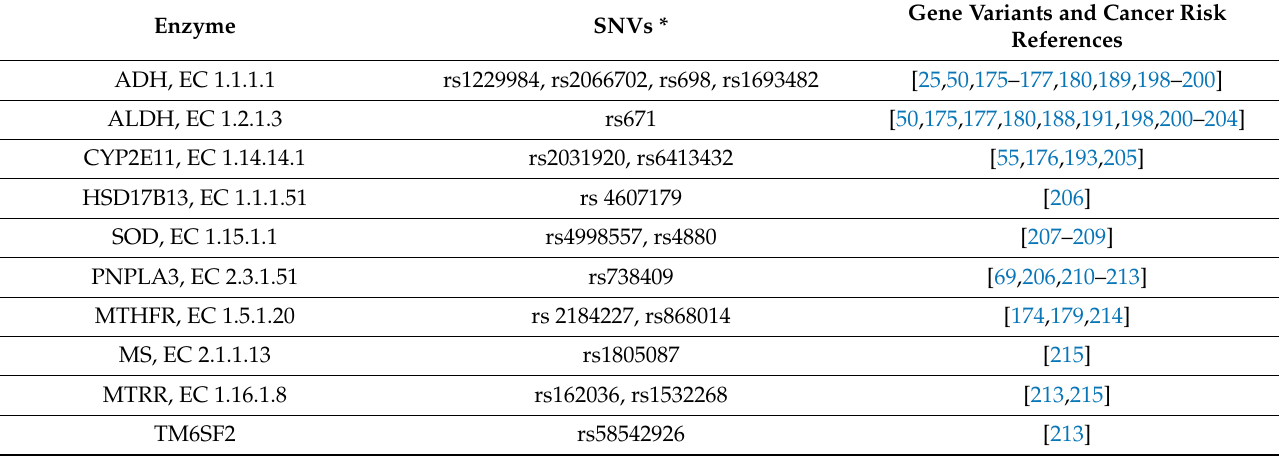
Table 1. Representative examples of enzyme variants liaised to cancer risk participating in alcohol metabolism or other metabolic pathways related to alcohol metabolism. The four EC digits represent the nomenclature assigned by the Enzyme Commission (EC) of the International Union of Biochemistry and Molecular Biology (IUBMB) [196] (accessed on 1 April 2021). The nomenclature rs (RefSNP) refers to gene variants named after The Single Nucleotide Polymorphism Database (dbSNP) [197] (accessed on 21 March 2021). HSD17B13, hydroxysteroid 17-beta dehydrogenase; MS, methionine synthase; MTHFR, methylenetetrahydrofolate reductase; MTRR, methionine synthase reductase; PNPLA3, patatin-like phospholipase domain-containing protein 3 or adiponutrin; GSH, reduced glutathione; TM6SF2, transmembrane 6 superfamily member 2; SNV, single nucleotide variants. * indicates that the single nucleotide polymorphism (SNP) is a single variant, SNV, appearing in the population with a 1% frequency or